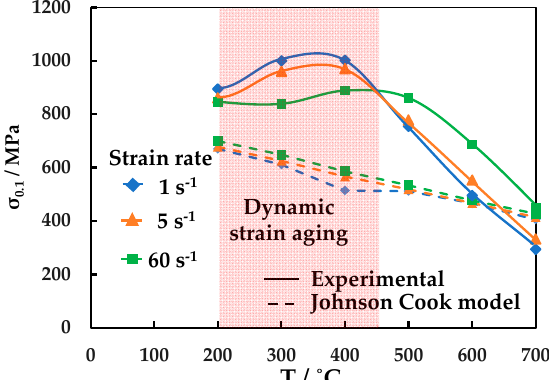
Figure 6. Flow stress at a true plastic strain of 0.1 versus temperature modeled using the original J-C model.